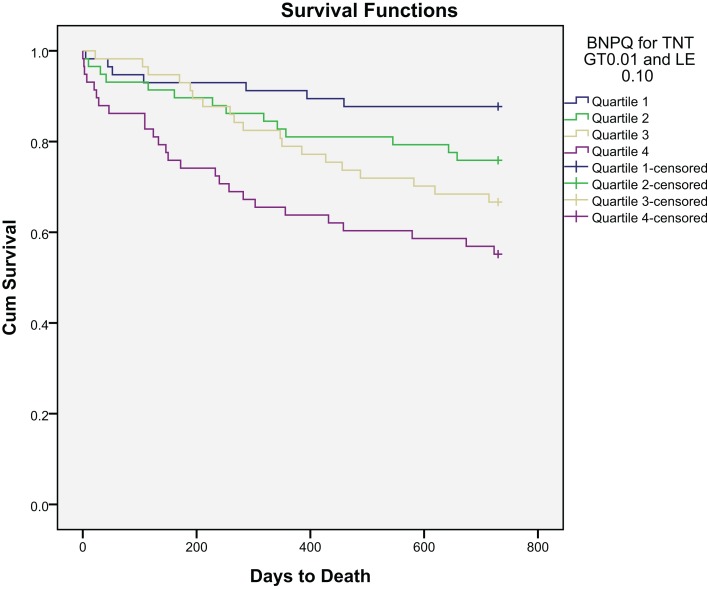
Kaplan–Meier plot of time to all-cause mortality within 2 years by BNP quartiles.